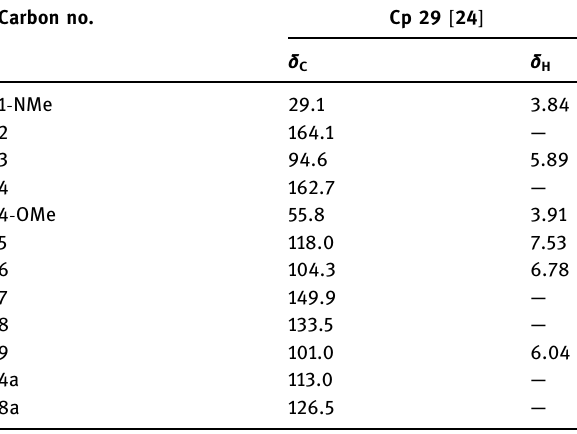
Table 9: 13 C and 1 H NMR chemical shift data ( δ , ppm ) of alkaloid isolated from genus Casimiroa Carbon no.